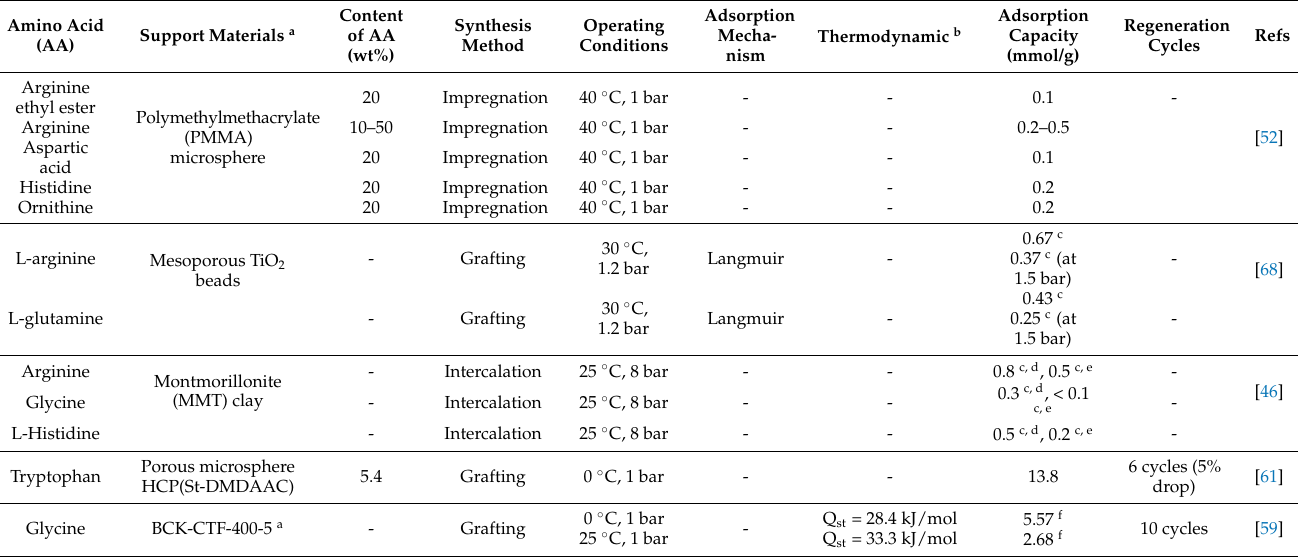
Table 8. Amino acid impregnated or grafted into various types of support